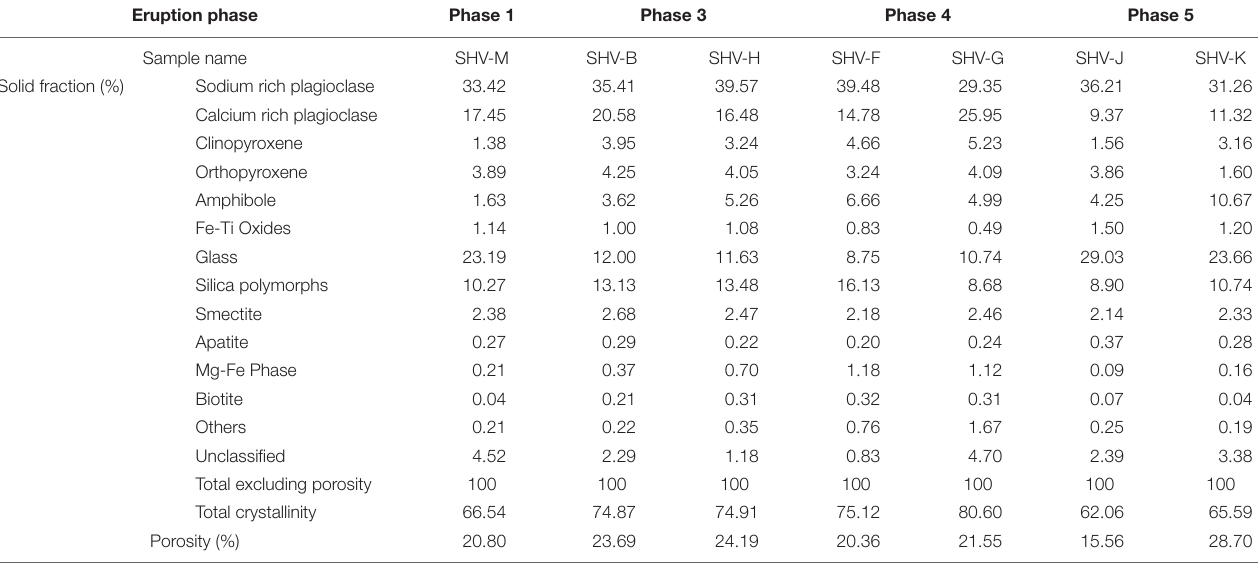
TABLE 2 | Quantitative analysis of mineral phases present in each sample, calculated as a percentage area of the solid fraction, and porosity as % of total area, using the 10- µ m resolution QEMSCAN analysis of a 10.1 mm × 10.1 mm area.